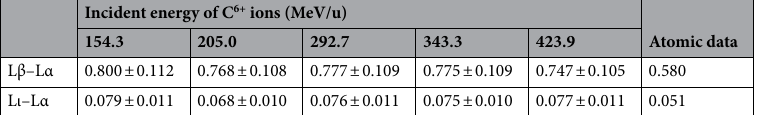
Incident energy of C 6+ ions